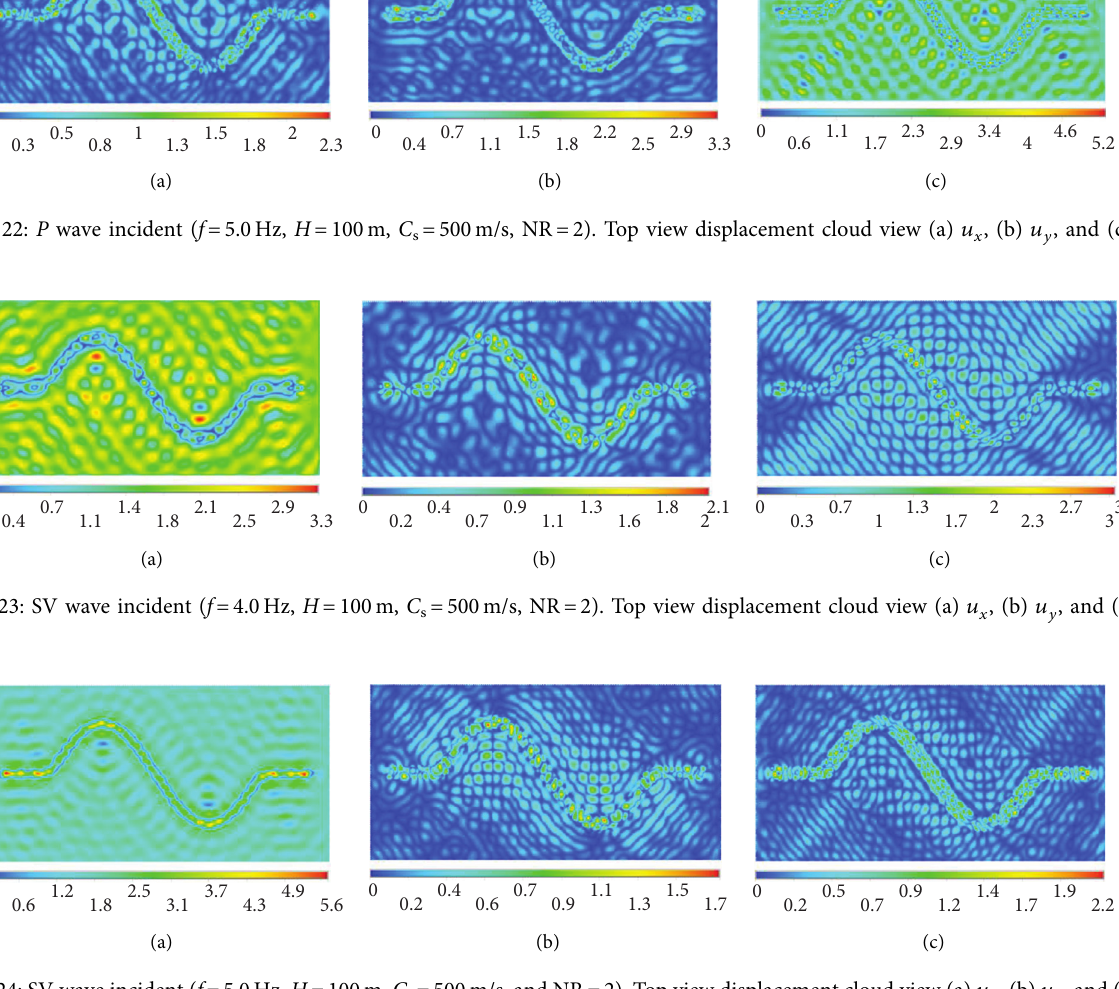
� 500 m/s, and NR � 2). Top view displacement cloud view (a) u s